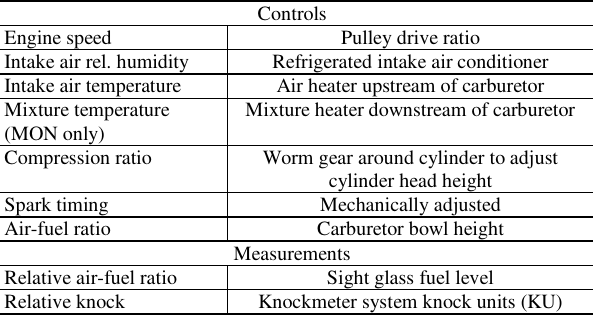
Table 3. Waukesha CFR F1/F2 engine controls and